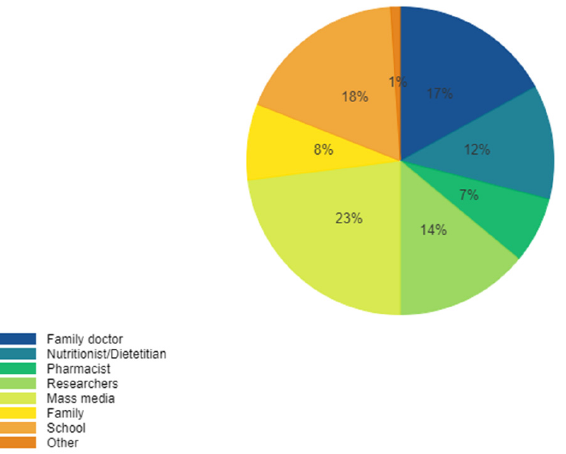
Figure 7. Perception on the stakeholders responsible for consumer’s information on prebiotics.